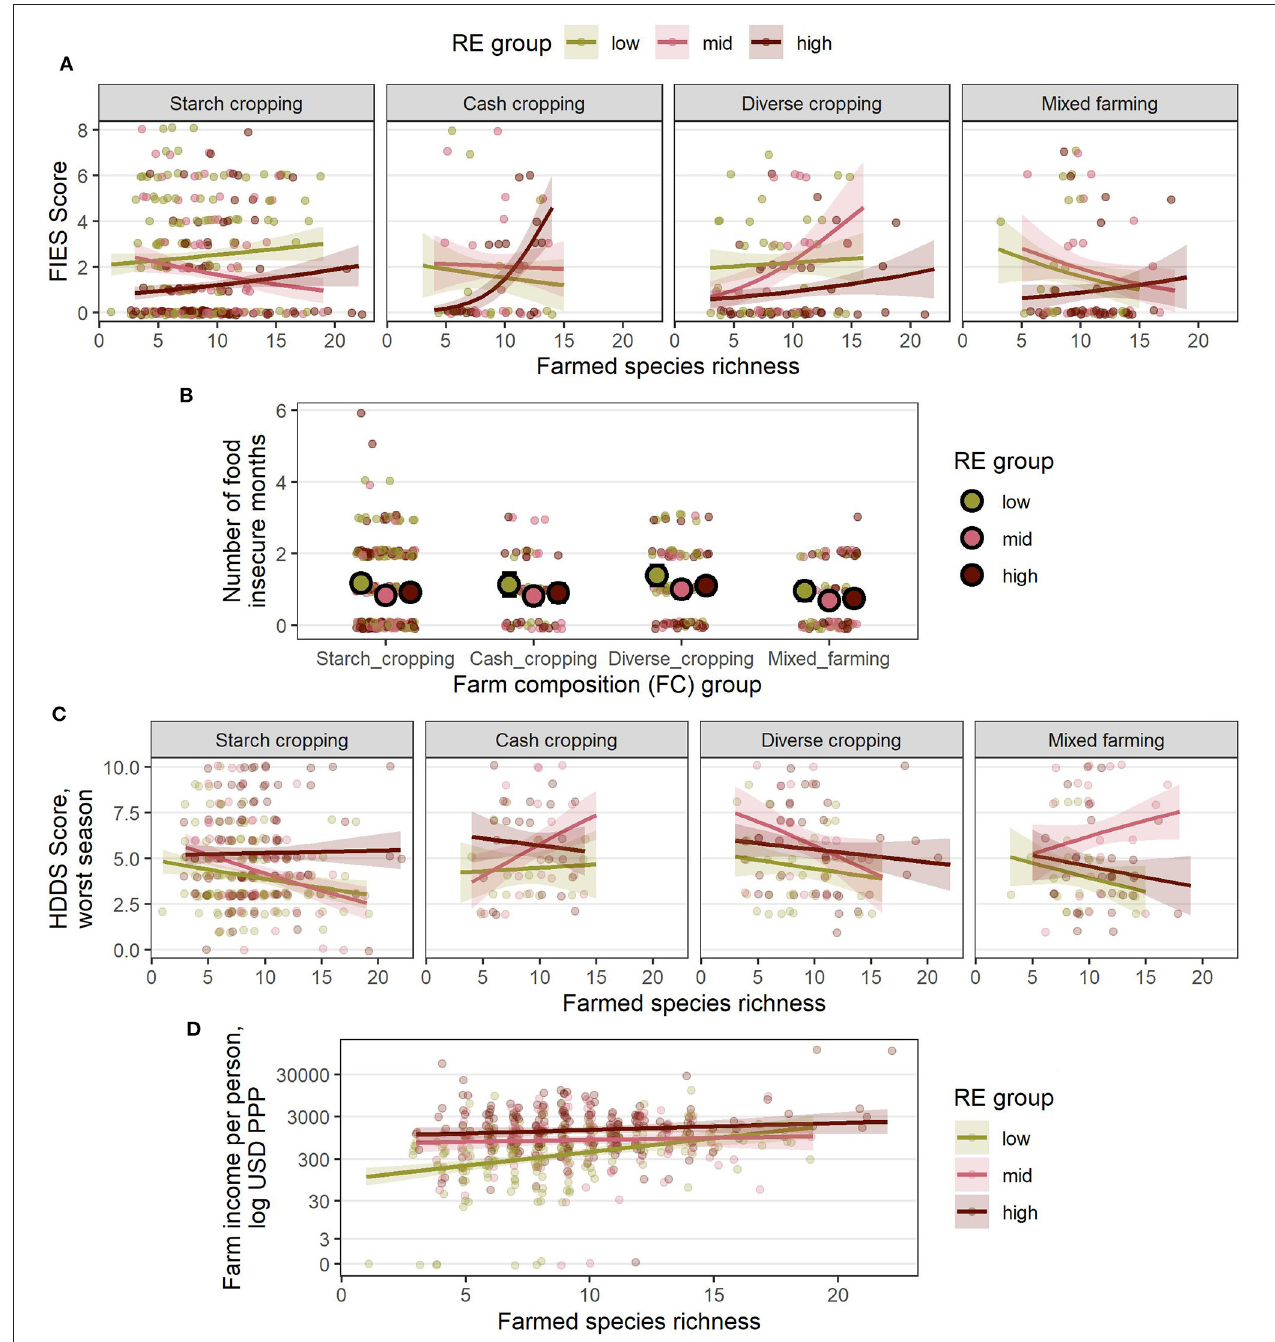
FIGURE 8 | Estimated relationships between livelihood outcomes in Nigeria and the combinations of RE groups, FC groups and species richness (SR) derived from the final, reduced models (A) FIES score, (B) number of food insecure months, (C) HDDS in the worst season, and (D) farm income per person, USD PPP. For (A–D) , lines indicate the estimated mean response, while shaded ribbons indicate 95% confidence intervals for the mean response. For (B) , large points indicate group means for each RE and FC combination and error bars indicate 95% confidence intervals (SR was not included in the reduced model of food insecure months in Nigeria). Graphs include extrapolation of the estimated relationships beyond the observed ranges of farmed species richness, to enable comparison of the shapes of the responses for different combinations of RE and FC groups, but extrapolated estimates should be interpreted with caution. Estimated responses for (A–C) are back-transformed from the logit scale on which the models were fitted. Estimated responses for (D) are shown on the log-transformed scale used for analysis (although axis labels show values on the linear scale). Points show individual (raw) datapoints from the survey responses jittered around the true value so points do not obscure one